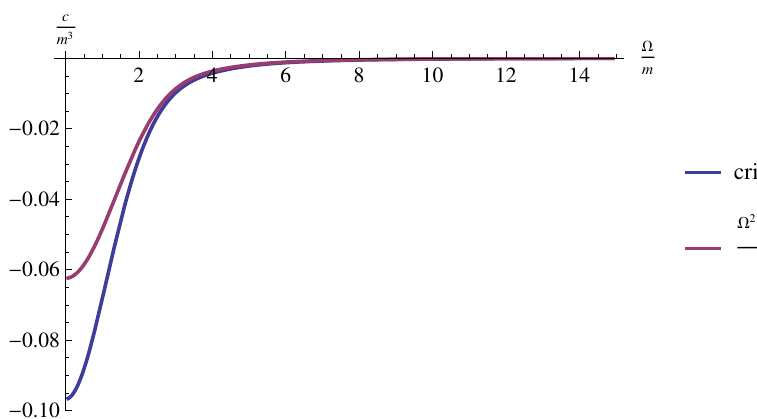
Figure 14 . The quark condensate for the critical solutions. The red curve is an approximate formula given by eq. (6.18), and the blue curve is the critical value obtained numerically. By introducing C = (cid:11) and C = (cid:12) + i(cid:13) ( (cid:11); (cid:12); (cid:13) 2 R ), 9 its general solution is given 1 2